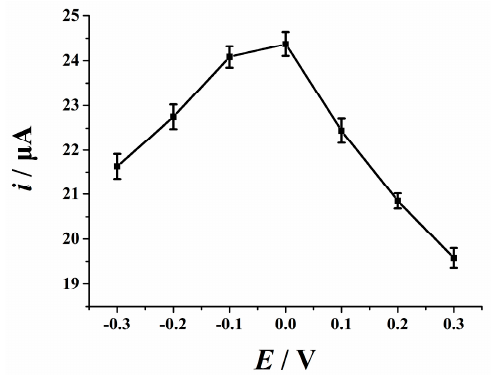
Figure 7. The effects of accumulation potential on the oxidation of 10 μ M vanillin in 0.1 M H 2 SO 4 solution at Cu 2 O NPs-ERGO/GCE. Accumulation time: 90 s, scan rate: 0.1 V s − 1 . Error bars represent SD, n = 3.